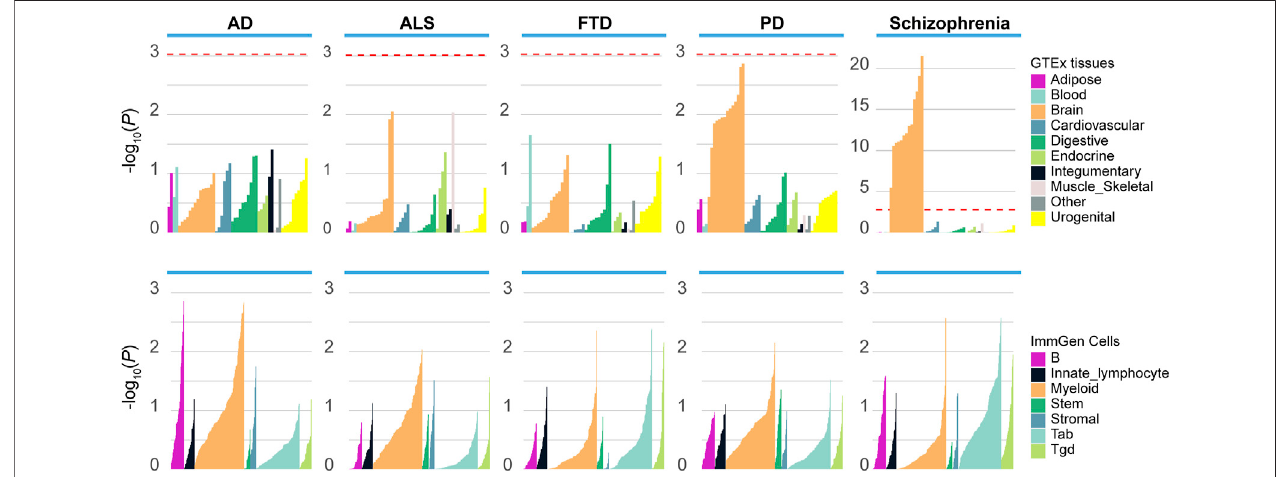
FIGURE 1 | Enrichment of tissues and cell types in schizophrenia and neurodegenerative diseases. Top panel: Regions of the genome with speci fi c expression in central nervous system (CNS) tissues are highly enriched for schizophrenia and PD, among 53 tissues obtained from the Genotype-Tissue expression project (GTEx). Bottompanel:LDSC-SEGanalysisusing292immune cellsfromtheImmGen Consortium. ALS, amyotrophic lateral sclerosis; PD,Parkinson ’ sdisease; AD, Alzheimer ’ s disease; FTD, frontotemporal dementia. The red dashed line denotes the signi fi cance level after the Bonferroni correction.